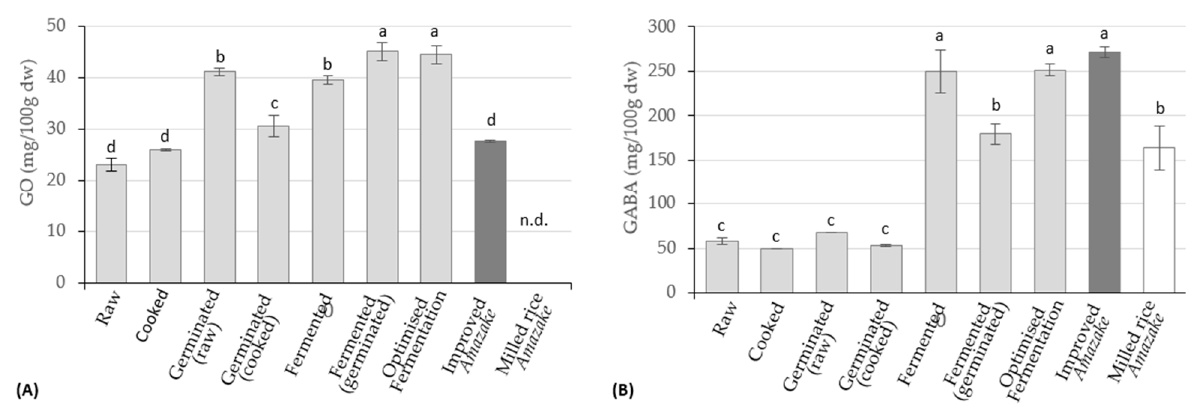
Figure 5. Effect of the various procedures on brown rice on ( A ) GO and ( B ) GABA contents. (n.d. stands for non-detectable). a, b, c, d—homogeneous groups according to the Tukey’s post hoc test at a 95% confidence level. The improved Amazake is shown in dark grey and the traditional milled rice Anazake in shown in white.